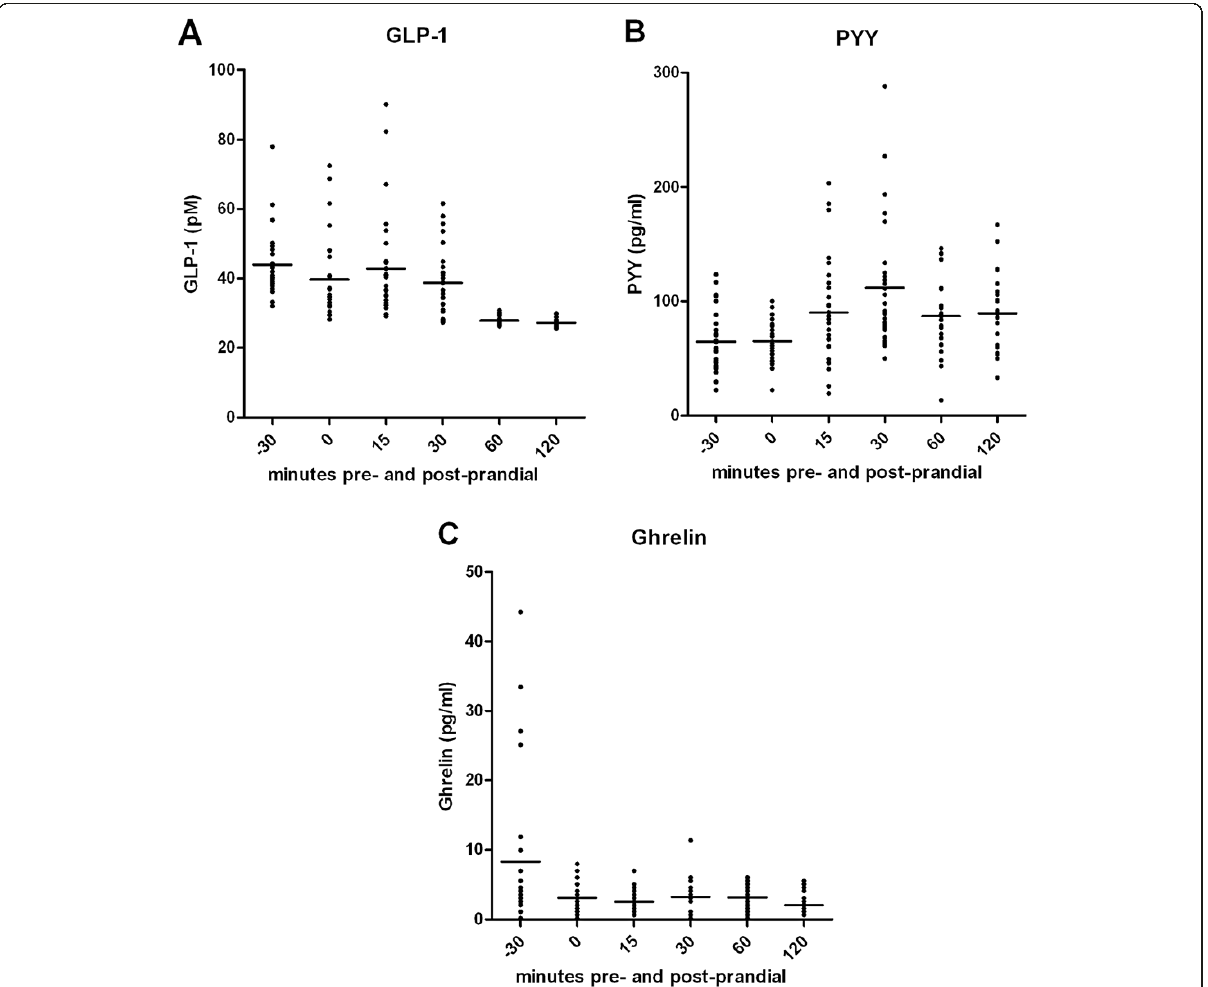
Figure 1 Distributions of pre- and post-prandial gut hormone levels. The horizontal lines in each figure are